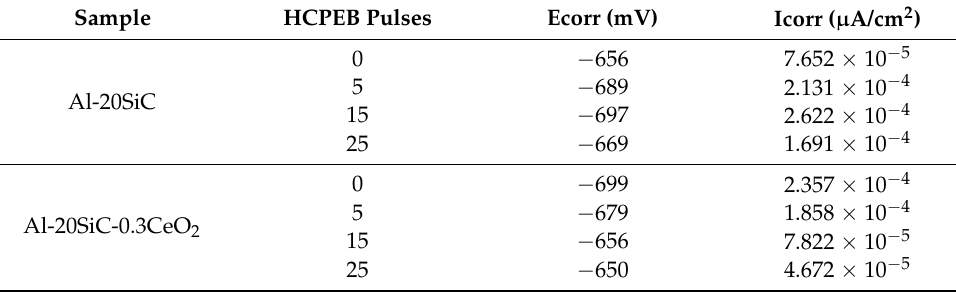
Figure 5. CP curves of PM alloy samples before and after HCPEB irradiation in 5-wt.% NaCl solution. ( a )Al-20SiC; ( b )Al-20SiC-0.3CeO 2 . Table 1. Electrochemical parameters obtained in the corrosion measurements.